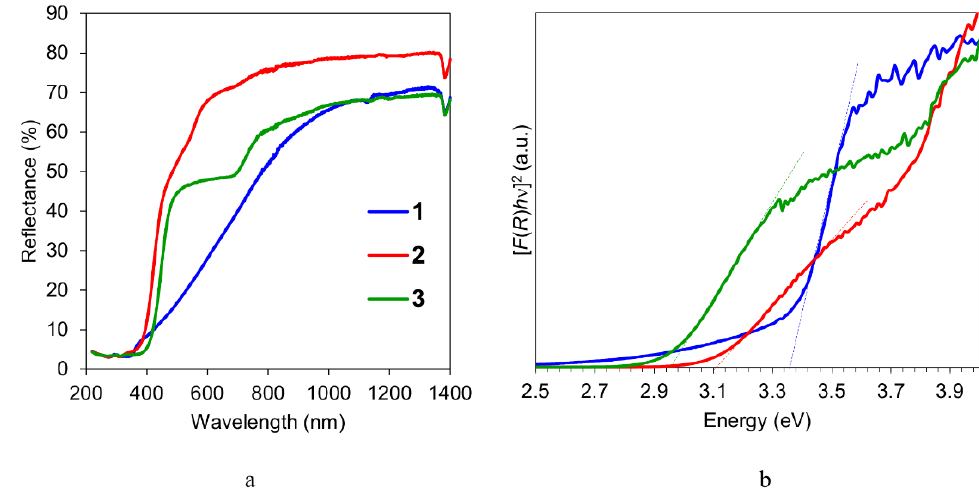
Figure 13. Diffuse reflectance spectra measured using powder samples of 1 – 3 at r.t. ( a ) and the Tauc plots in the range 2.5–4 eV based on the assumption of direct band gap calculated from the reflectance spectra of 1 – 3 ( b ).